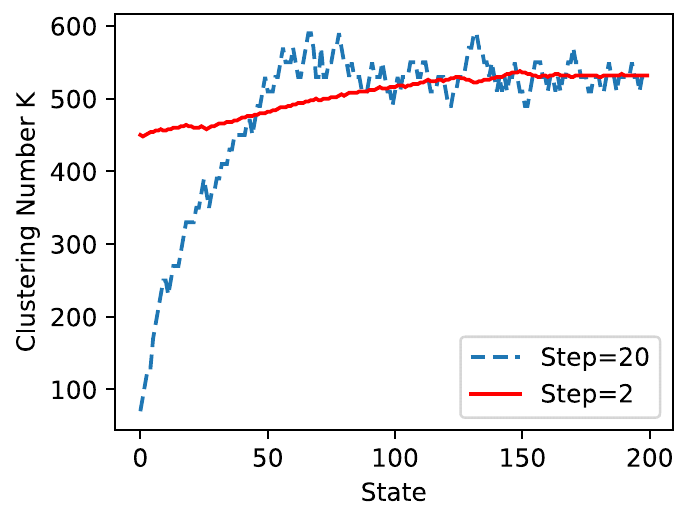
Figure 11. The path of searching for the optimal clustering number K on the CFP Face Database.